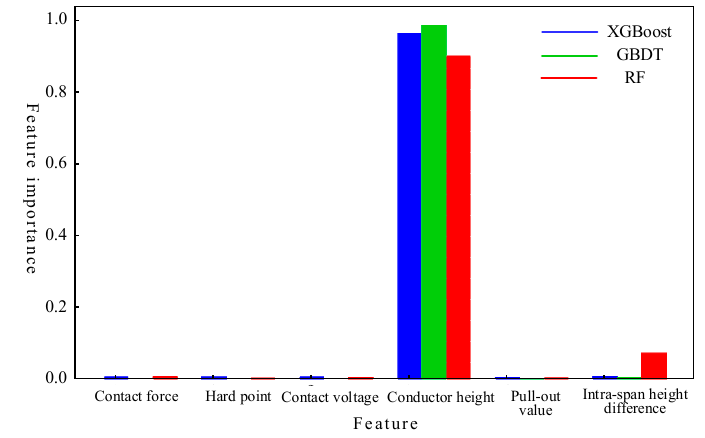
Figure 5. An examination of how various algorithms contribute to features.